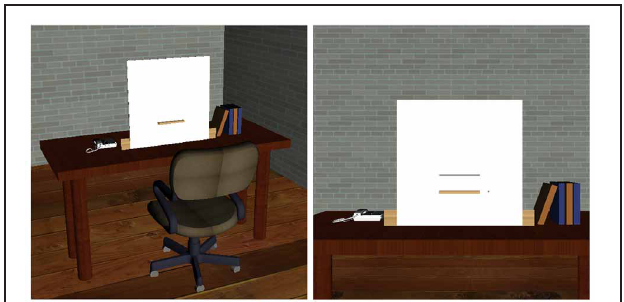
FIGURE 2 | The virtual environment. On the left, a panoramic view of the virtual room is presented; the mobile chair with wheels was created to simulate and motivate the movement along the distances of line presentation, 60 and 120cm. On the right, the participants’ point of view of the virtual environment is presented; lines were presented over the white panel and could be bisected moving a red dot through the manipulation of a Nintendo Wiimote ®